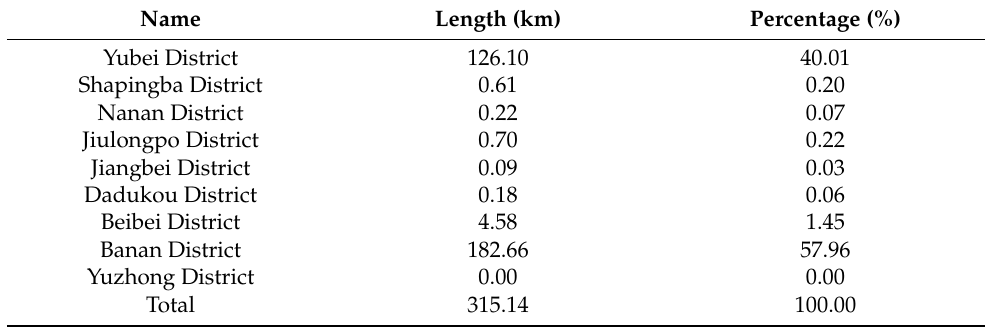
Table 8. Ecological corridor length statistics.